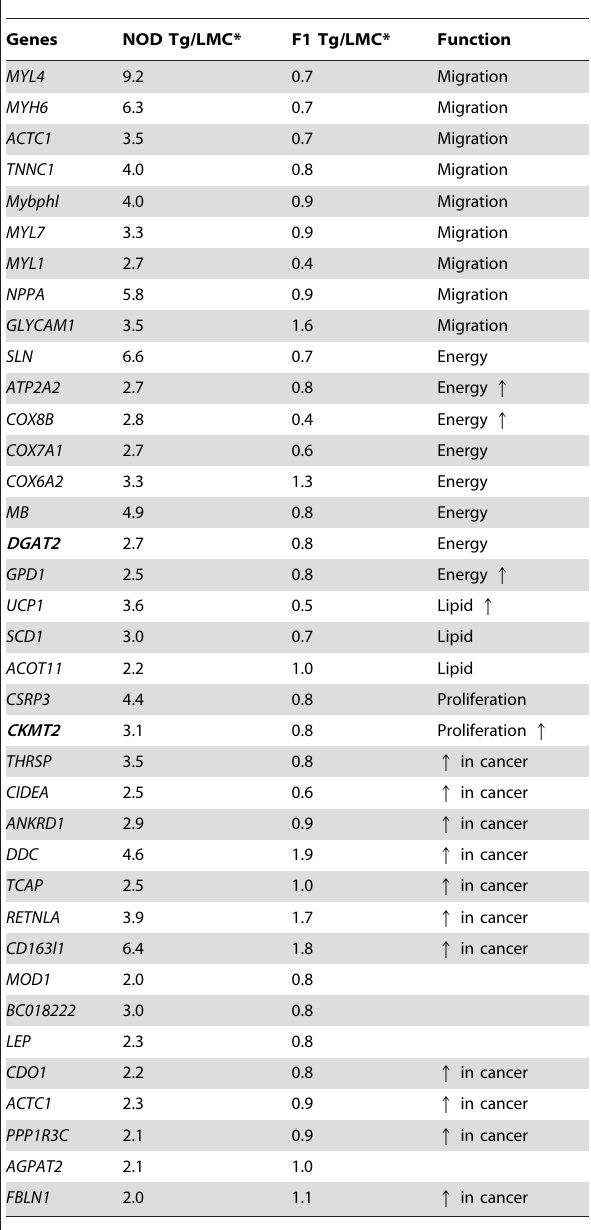
Table 2. Genes up-regulated in the NOD.Stat5b Tg mice but not in the F1.Stat5b Tg